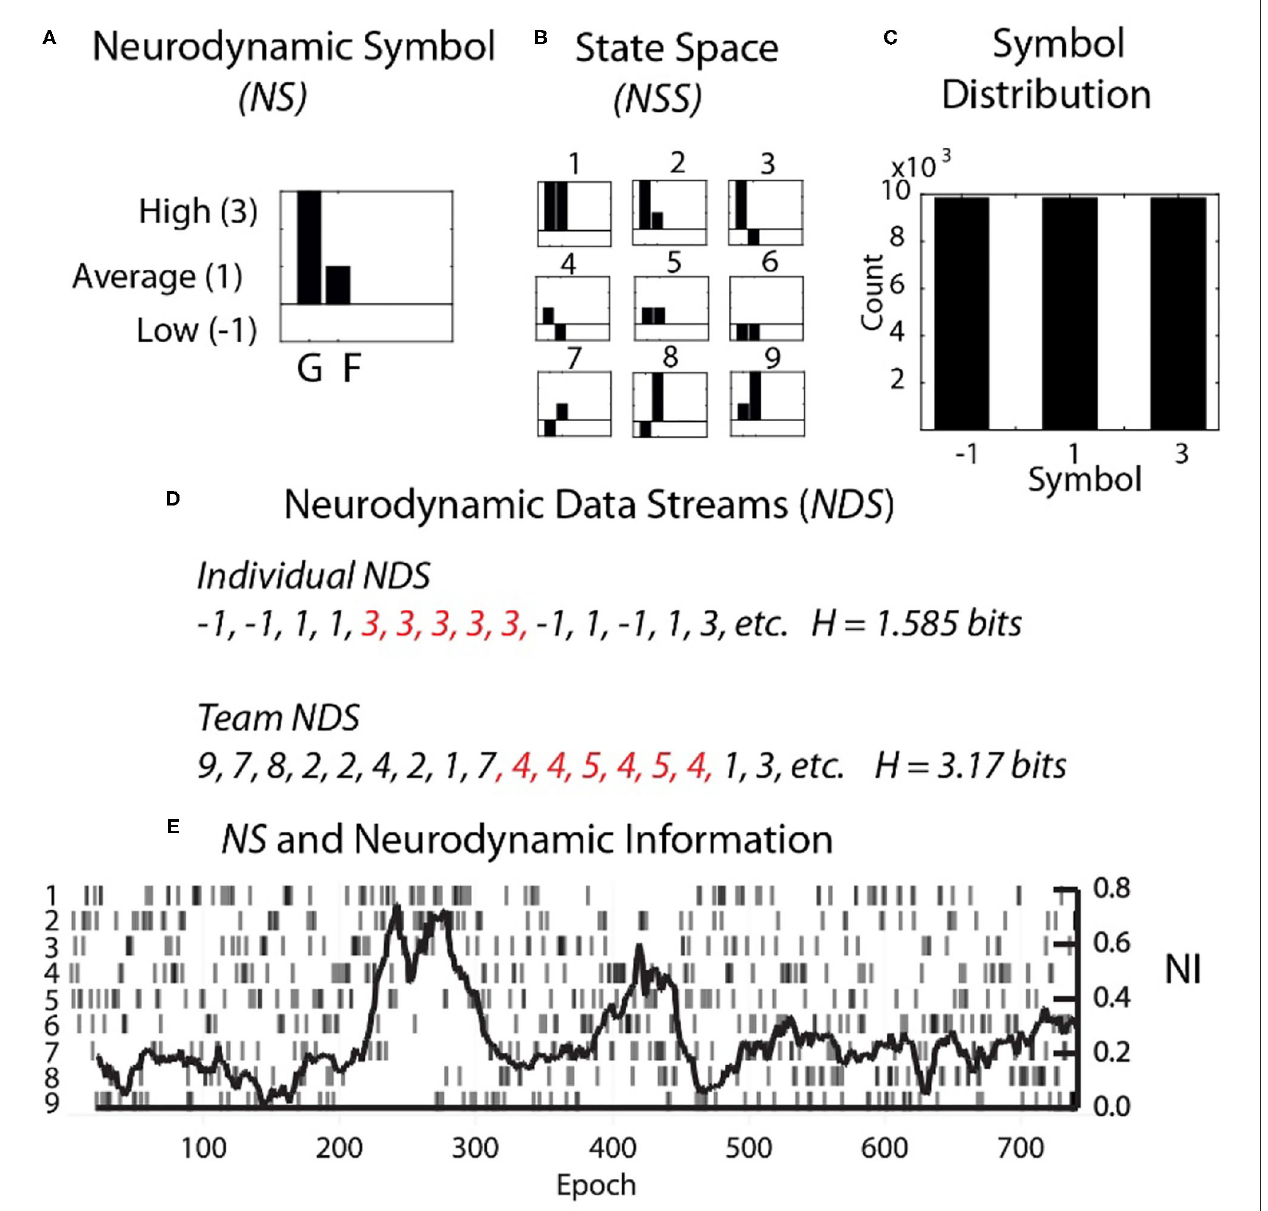
FIGURE 2 | Team and individual neurodynamic modeling of a dyad. (A) A sample Neurodynamic Symbol ( NS) showing a 1s period where the EEG power was high for team member 1 (G), and average for team member 2 (F). (B) The nine-symbol Neurodynamic State Space ( NSS) for two persons with three EEG power levels. (C) The distributions of the − 1, 1, and 3 symbols need to be equal for accurate quantitative entropy comparisons. (D) Neurodynamic Data Streams ( NDS ) are symbol sequences that span the performance. For a dyad they are the team symbols in Figure 2B , while for individual team members they would be the − 1, 1 and 3 values used symbolically. Note in Figure 2D that the symbol expression for both team and individual NDS were not random but punctuated by periods of symbol repeats which elevated the NI. Periods of symbol repeats were quantitated using entropy calculations over a 60s window that was updated each second. (E) The NDS and the neurodynamic information tracing is shown for the dyad at the C3 sensor for the 18 Hz frequency.